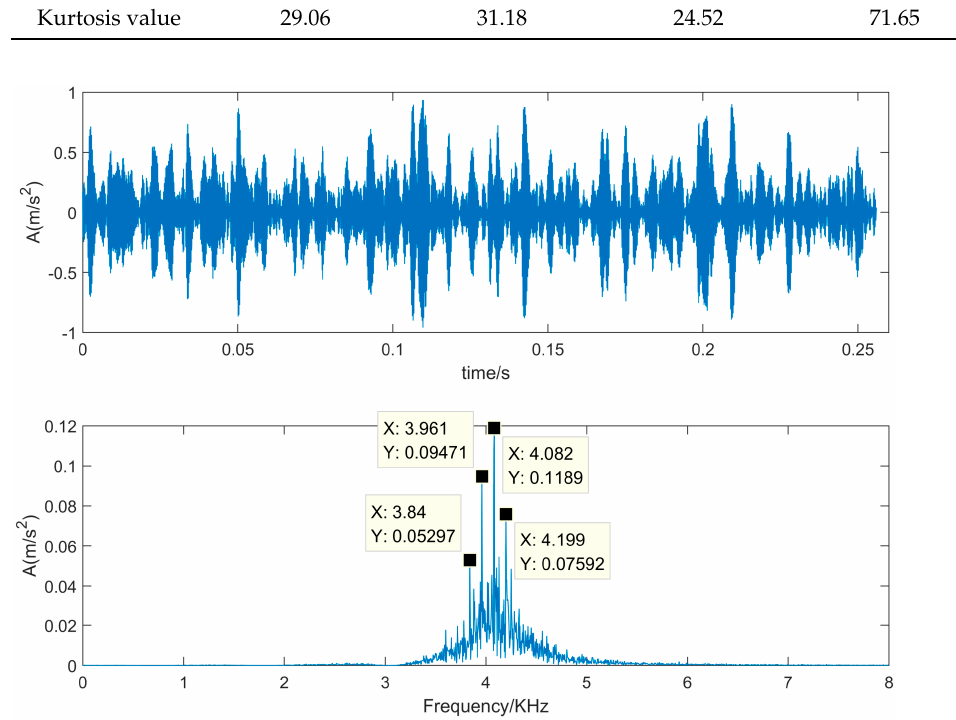
Figure 6. Denoised signal by using SVD-VMD algorithm.